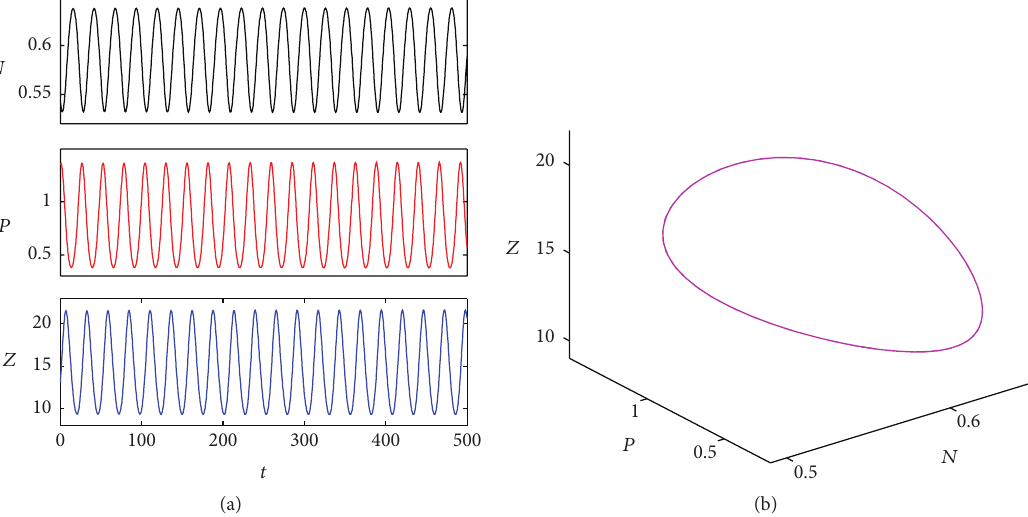
Figure 3: Numerical solutions of system (3) with 𝛼 = 0.2819 , 𝜏 = 10 , and initial point (0.6, 0.7, 15). (a) shows the time series of 𝑁 (black line), 𝑃 (red line), and 𝑍 (blue line) and (b) shows the associated phase diagram of system (3) (magenta line). There exists a positive period-1 solution of system